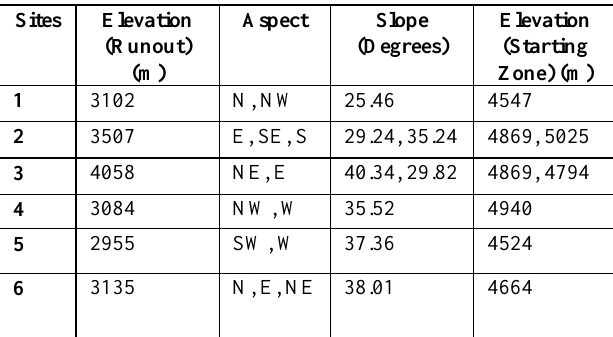
Table 1 Information of different avalanche sites in Alaknanda